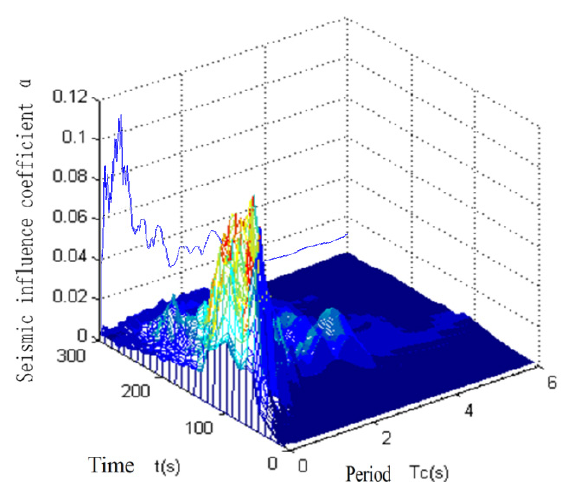
Figure 4. Flow chart for generating the time-domain seismic response spectral matrix.